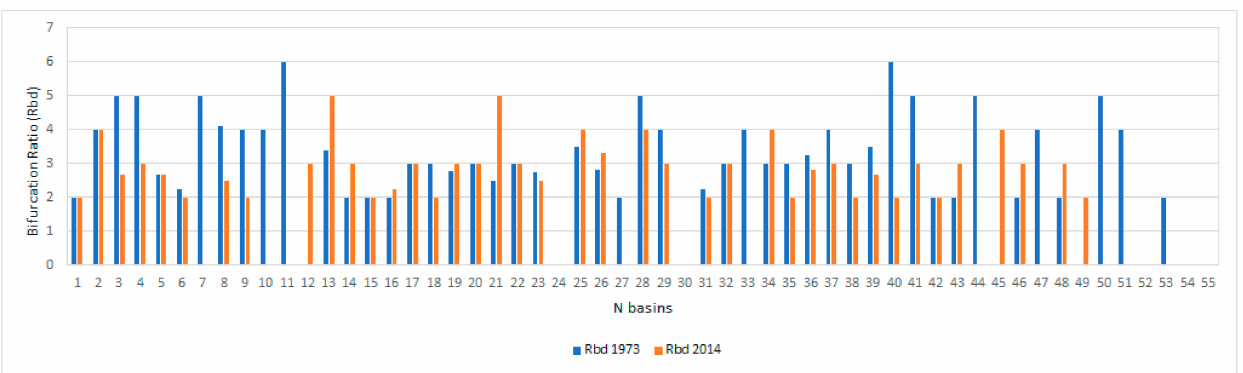
Figure 7. Variation of Bifurcation Radio (Rdb) values in 1973 (in blue) and in 2014 (in